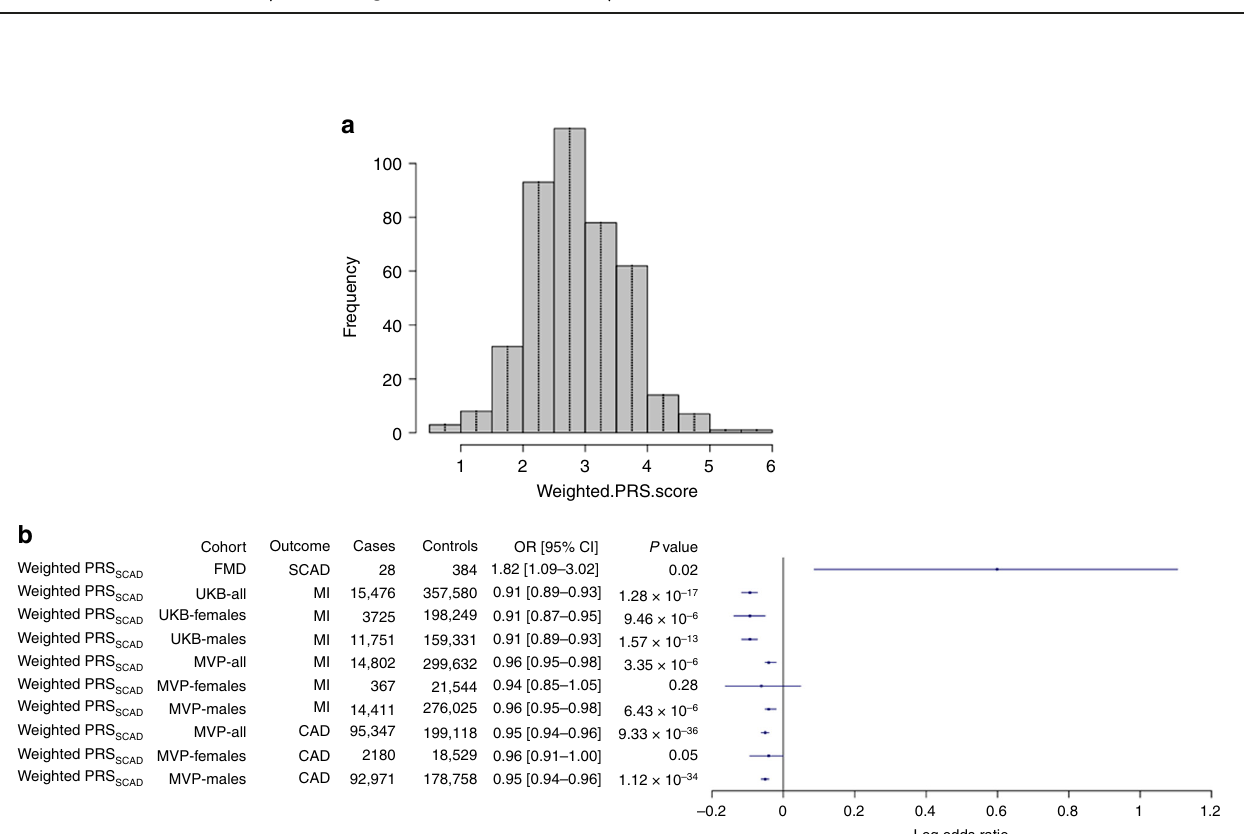
Fig. 3 Arterial expression of genes implicated by the SCAD GWAS meta-analysis. a Colocalization analysis results in which the lead SNP identi fi ed matched the queried transcript are shown for each locus identi fi ed. The locus-compare scatter plot compares linear regression eQTL ( n = 913) and GWAS results ( n = 8903), using the same method as Fig. 2a, in the gene region, which indicates whether the GWAS top locus is also the leading SNP in the eQTL result, supporting the conclusion that both traits are associated and share a single causal variant. P values are two sided and unadjusted for multiple testing. The gene prioritized in each locus is shown on the y -axis and corresponding fi gure label. b Boxplots of transcript expression levels by sex ( n = 913, which includes 593 males and 320 females) are displayed for each gene prioritized by the colocalization analysis. Transcript expression levels are measured in transcripts per million (TPM). Gene TPMs were downloaded from the GTEx portal (v7) and subset to include only values from coronary artery tissue. The median of each gene is represented as the center horizontal line within each box, colored light purple for females and light blue for males. The top boundary of the box for each gene represents the 75th percentile of associated TPM values and the bottom boundary of the box represents the 25th percentile. The end point of the whiskers extending from each box mark the minimum and maximum TPM values, respectively. c Expression QTL results in GTEx arterial tissues. Violin plots depict normalized expression by allele. Two-sided values of linear regression P values listed represent calculated association between genotypes of each listed SNP and the corresponding eGene of interests referenced in a , b . d Arterial ADAMTSL4 immunostains of normal human coronary artery showing staining (brown) in the arterial media (×20), with nuclei stained blue. Inset bar = 100 µ m. e In situ hybridization of normal human coronary artery with ADAMTSL4 mRNA (red) detected in the arterial media and with alpha actin (green) with nuclear DAPI staining (blue) co-localization to smooth